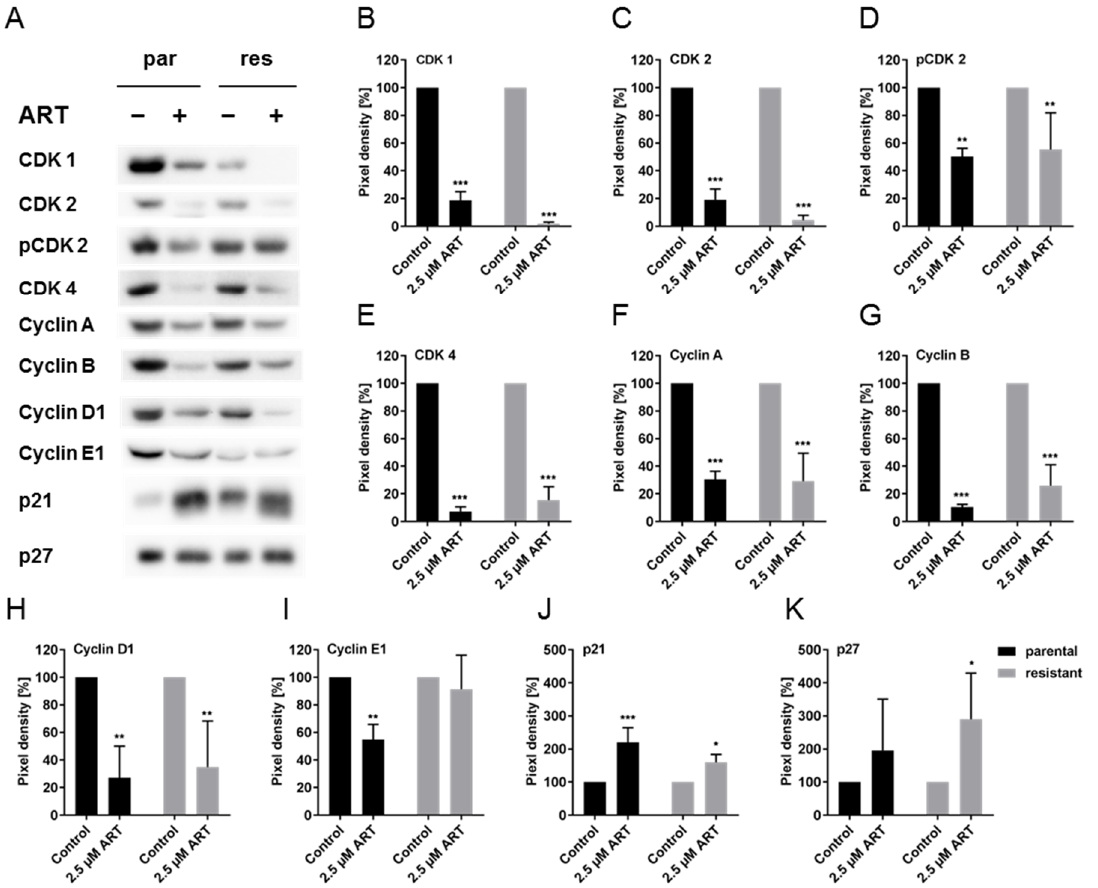
Figure 4. Protein expression profile of cell cycle regulating proteins: Representative Western blot analysis of cell cycle regulating proteins in parental (par) and cisplatin-resistant (res) T24 cells after 48 h exposure to 2.5 µM ART ( A ). Pixel density analysis of protein expression ( B – K ), compared to untreated controls (set to 100%), is illustrated. Each protein analysis was accompanied and normalized by a total protein control. Error bars indicate standard deviation ( SD ). Significant difference to untreated control: * p ≤ 0.05, ** p ≤ 0.01, *** p ≤ 0.001. n = 3. For detailed information regarding the Western blots see Supplementary Materials Figure S1.